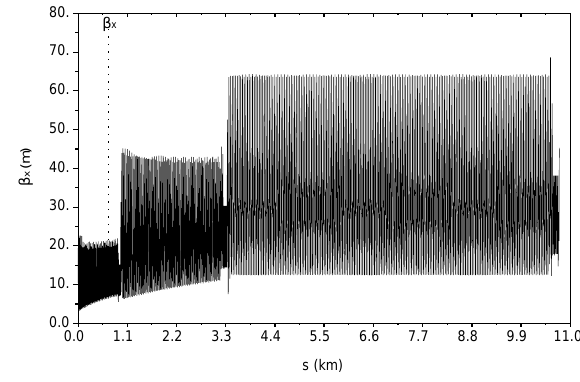
FIG. 1. Horizontal beta function in the NLC